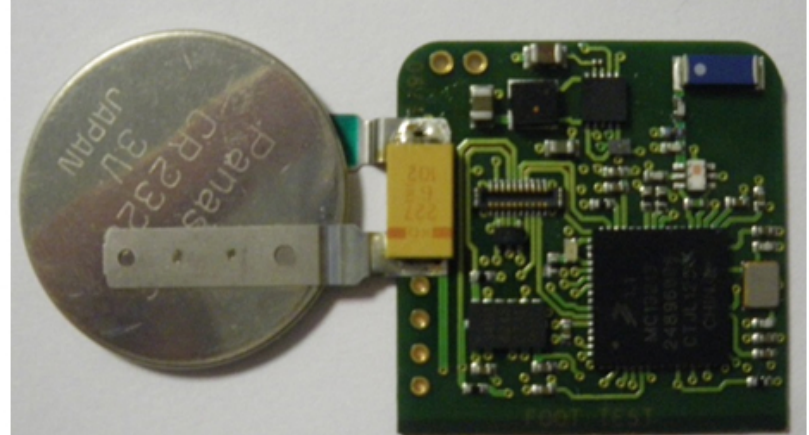
Figure 2. Sensors